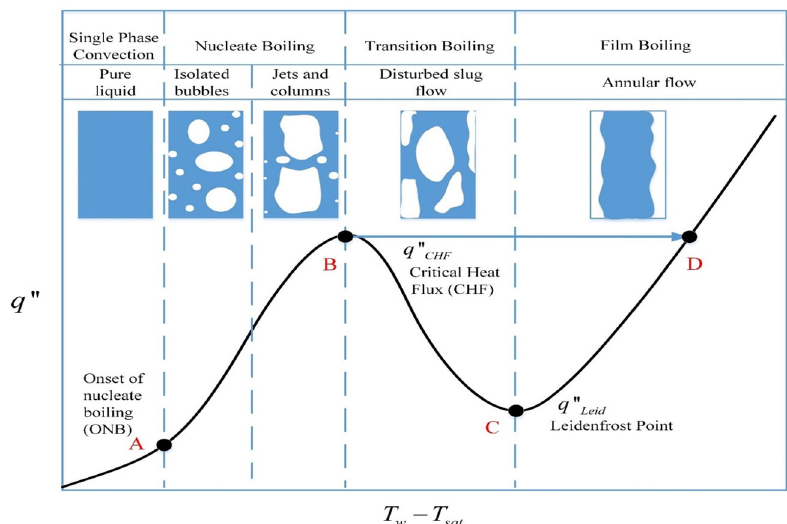
Fig. 1 A typical boiling curve and quenching heat transfer characteristics. A quenching (chilldown) process is a liquid-to-vapor phase change phenomenon that is governed by the “ boiling curve ” . This curve 24 shows the heat transfer surface heat fl ux, q ″ , plotted against the surface degree of superheating, T w − T sat , where T w is the tube wall inner surface temperature and T sat is the saturation temperature corresponding to the boiling fl uid bulk pressure. In boiling, if the heating source is externally supplied to the heater surface such as an embedded electrical resistance heating element, the process is heat- fl ux controlled and follows the route of A → B → D. In contrast, during quenching, the warm wall where the heat comes out does not have a heat supply, therefore, the heat transferring out of the wall can only come internally from the thermal capacity (stored energy) of the wall. The only way to remove heat from the wall is by lowering the inner wall surface temperature using a cooling fl ow. So quenching is a wall surface temperature-controlled process. Thus, a quenching process follows the route D → C → B → A. During quenching, fi lm boiling is always the fi rst mode of heat transfer encountered due to a relatively very hot surface. Owing to its very low heat fl uxes at high wall temperatures 25 – 27 , fi lm boiling usually dominates the quenching time and cannot be avoided in a traditional chilldown process. As a result, in traditional quenching processes, the thermal energy ef fi ciency is extremely low. According to Shaeffer et al. 5 , the average quenching ef fi ciency that is de fi ned as the ratio of the amount of thermal energy removed from the wall versus the required cooling capability of the cryogen spent in a quenching process is about 8% that highlights the tremendous need to improve the quenching ef fi ciency for many applications that require cryogens as the working fl